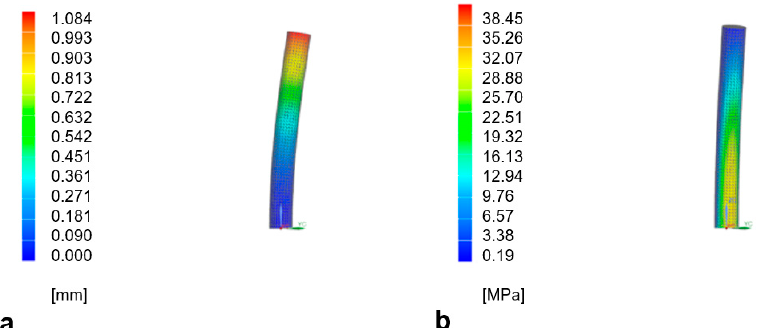
Figure 8. Displacement ( a ) and stress distribution ( b ) of the diagonal column with free–fixed boundary condition in the buckling analysis.